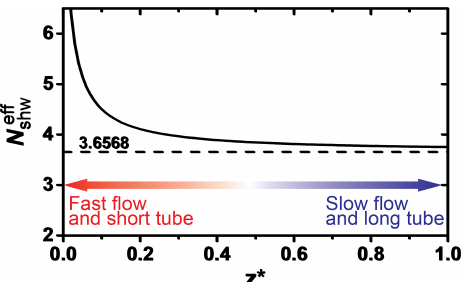
Figure A1. Dependence of the effective Sherwood number ( N eff on the dimensionless axial distance of the flow reactor. Smaller di- mensionless axial distance represents the scenario of a fast flow or short tube. Adapted from Davies (2008) and Knopf et al. (2015).